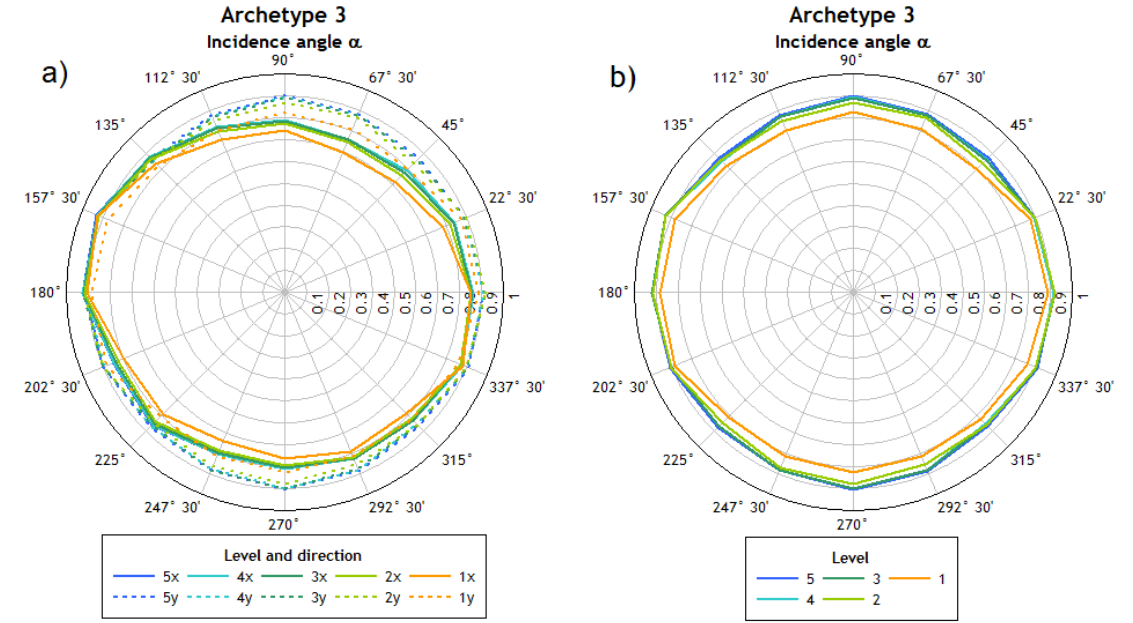
Figure 13. Mean interstory drift normalized for Archetype 3 per story, ( a ) without and ( b ) with SRSS combination.